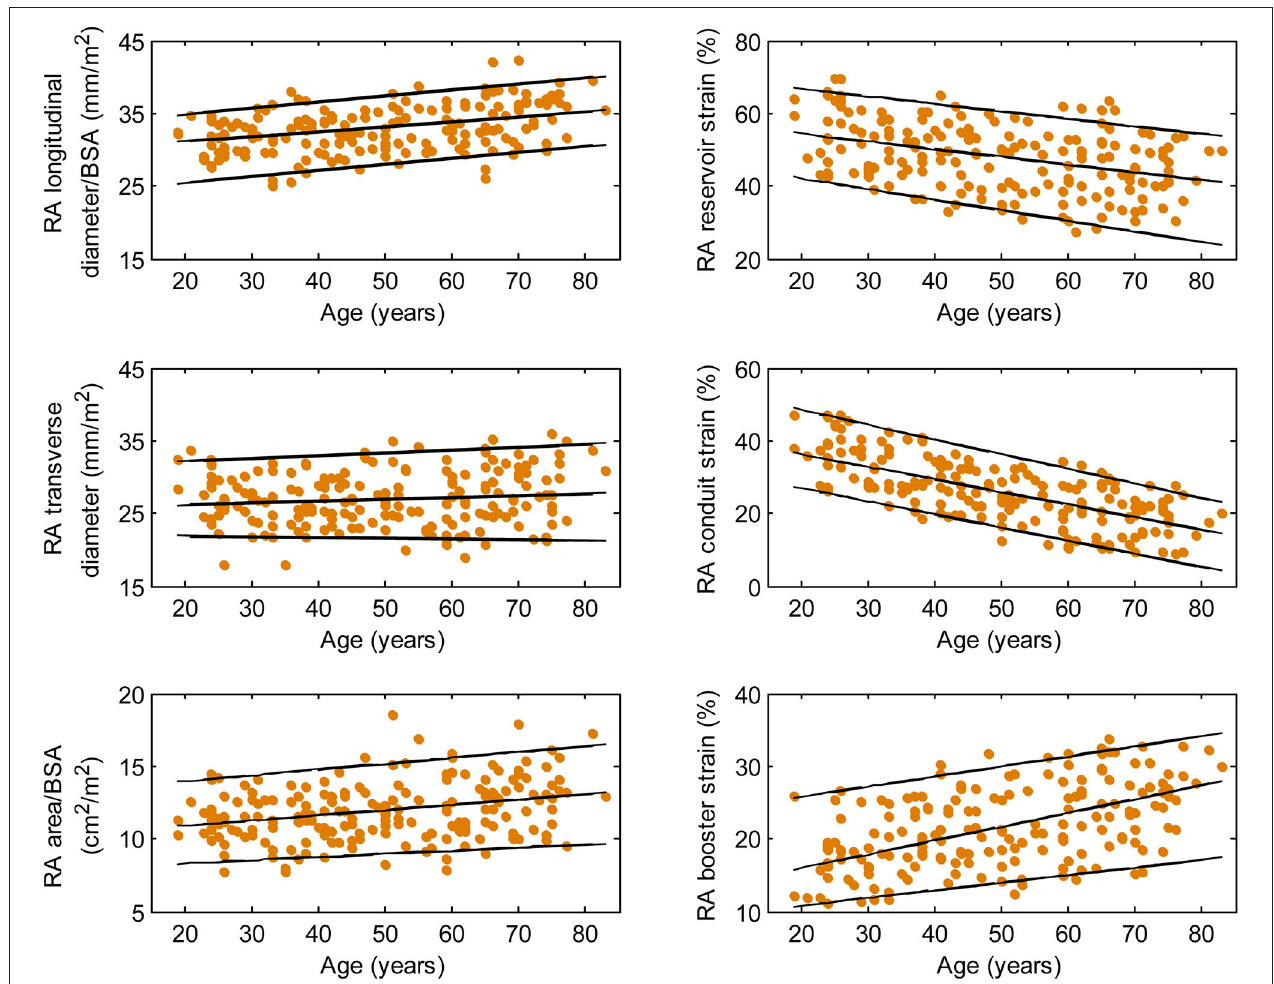
FIGURE 5 | Right atrial parameters plotted against age in female subjects. (Central line) The 50th percentile; (Top line) The 95th percentile; (Bottom line) The 5th percentile.